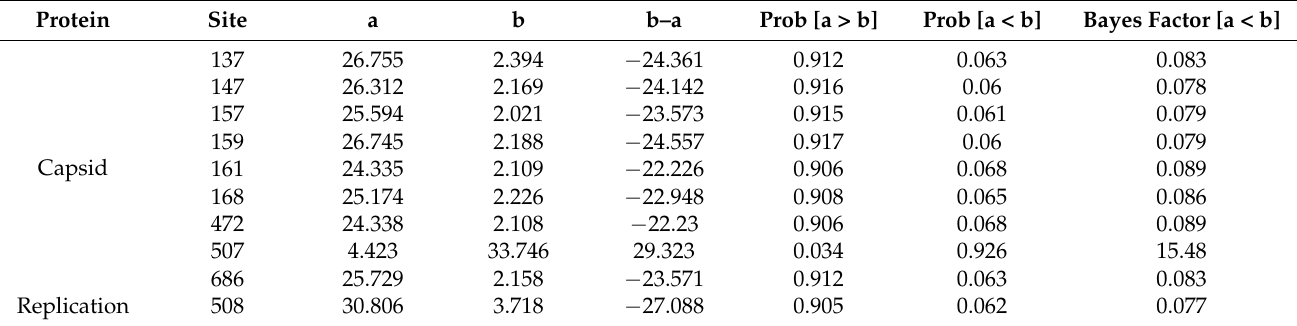
Table 8. Natural selection profile in waterfowl parvovirus capsid and replication protein of four current Vietnamese NGPV